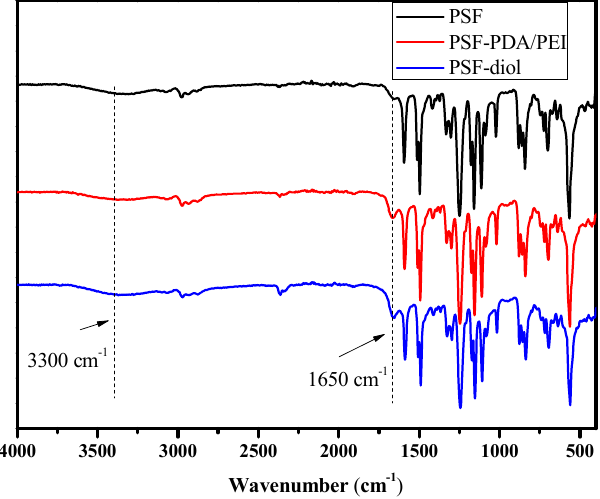
Figure 4. ATR-FTIR spectra of the PSF, PSF-PDA/PEI, and PSF-diol membranes.